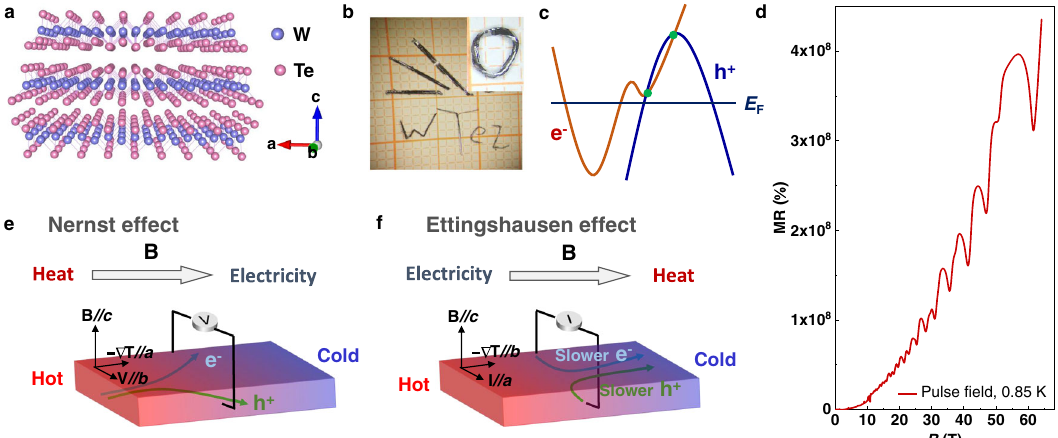
Fig. 1 WTe 2 basic properties and the Nernst – Ettingshausen effect. a Crystal structure of WTe 2 . Te – Te layers in the ab -plane are bonded by van der Waals forces and the crystals can be cleaved easily. b Photograph of WTe 2 single crystals, and the spelling of “ WTe 2 ” using arti fi cially deformed crystals. Inset shows a Möbius strip formed from a WTe 2 single crystal. c Schematic of the band structure of WTe 2 Weyl semimetal. Electrons and holes show nearly perfect compensation at the Fermi energy. The green dots show a pair of Weyl points, which are above the Fermi energy. d Magnetoresistance of the studied WTe 2 single crystal at 0.85 K recorded using a magnetic- fi eld pulse up to 65 T. e Schematic illustrations of Nernst effect. f Ettingshausen effect. The orientation of the experimental setup corresponding to the crystal axes is shown. Both the Nernst and Ettingshausen devices need only one material, and therefore have lower complexity than Seebeck